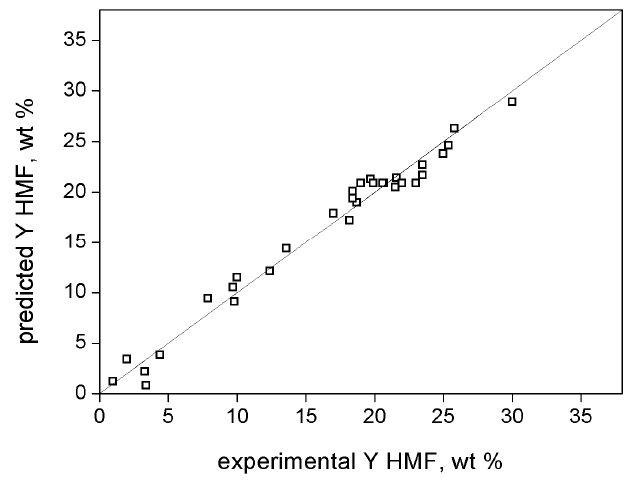
Figure 10. Parity plot for the HMF yield.